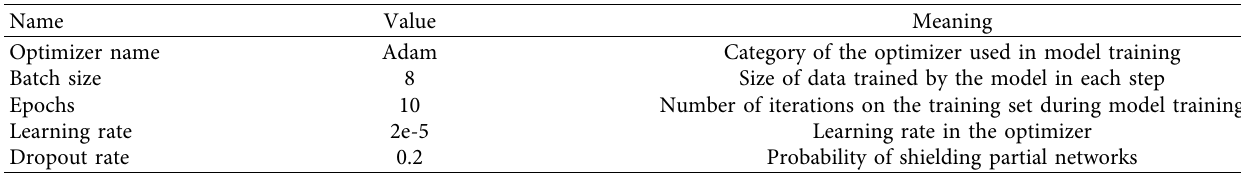
Figure 4: Analysis of different hyperparameter values. Table 3: Hyperparameter settings.